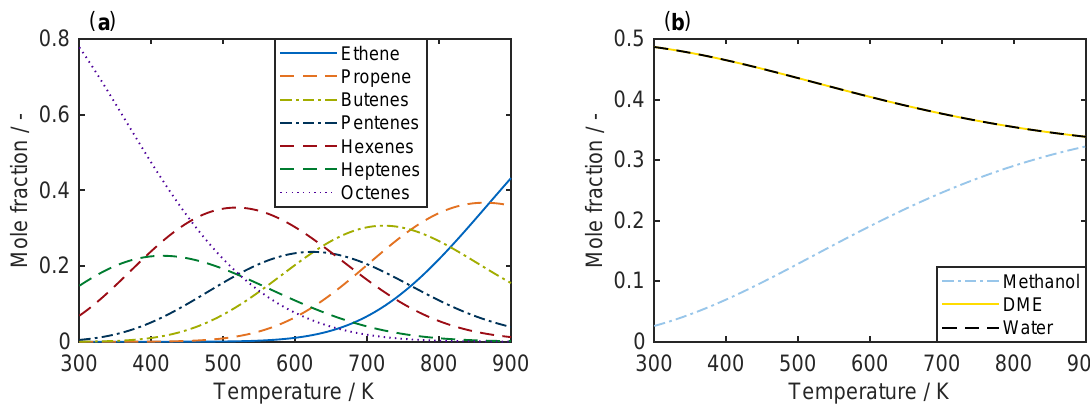
Figure 1. Composition of an equilibrated mixture as a function of temperature at standard pressure to C = ; and ( b ) for the system p t = p ◦ : ( a ) for C = 2 8